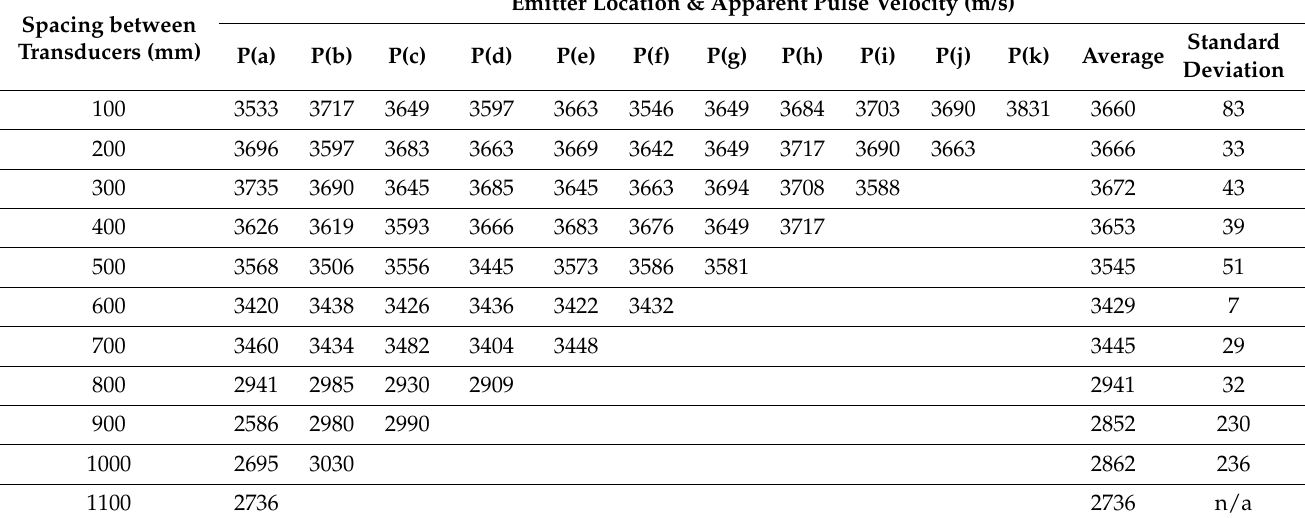
Table 3. The apparent UPV in plain